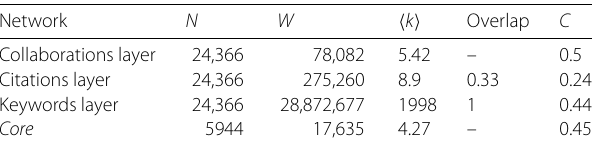
Table 1 Properties of the different layers of the scientific networks and the Core over which link prediction is computed. We show the number of nodes N , the total weight W = average degree (cid:2) k (cid:3) , the overlap between the collaboration layer and the other layers, and the global clustering coefficient C . The overlap is defined as the fraction of links in the collaboration layer that are also present in citations layer or keyword layers Network N W (cid:2) k (cid:3) Overlap